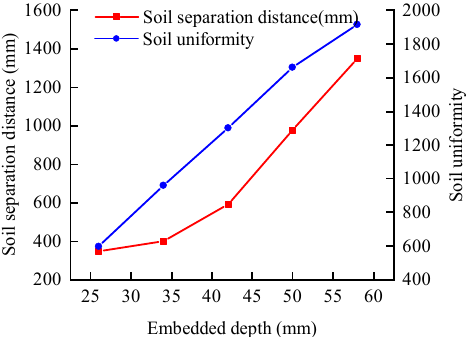
Figure 12. Relationship curves between embedded depth and D W , E .